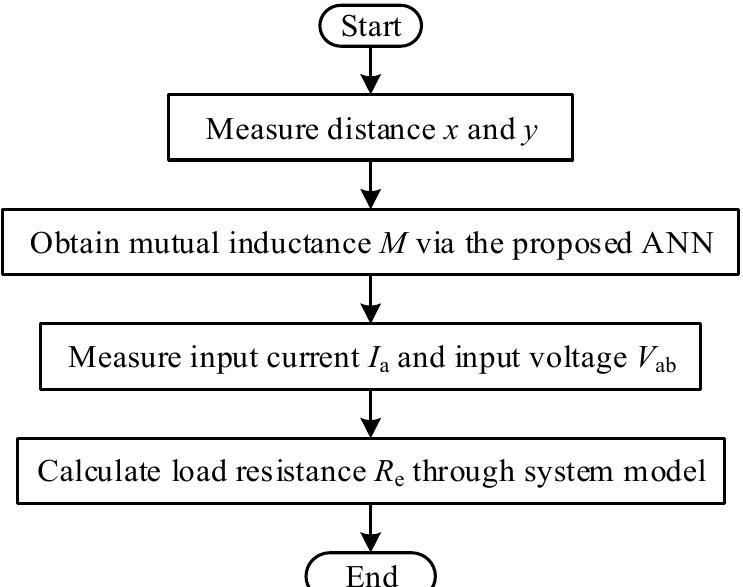
Figure 4. Diagram of coil misalignments versus different ( a ) vertical distances and ( b ) horizontal distances.